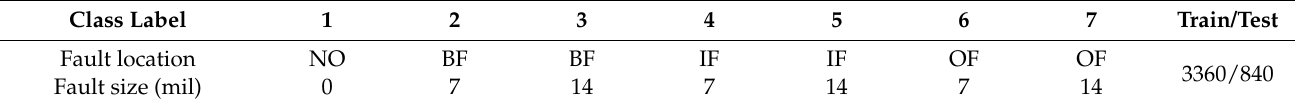
Table 2. The CWRU dataset details for each operating condition.